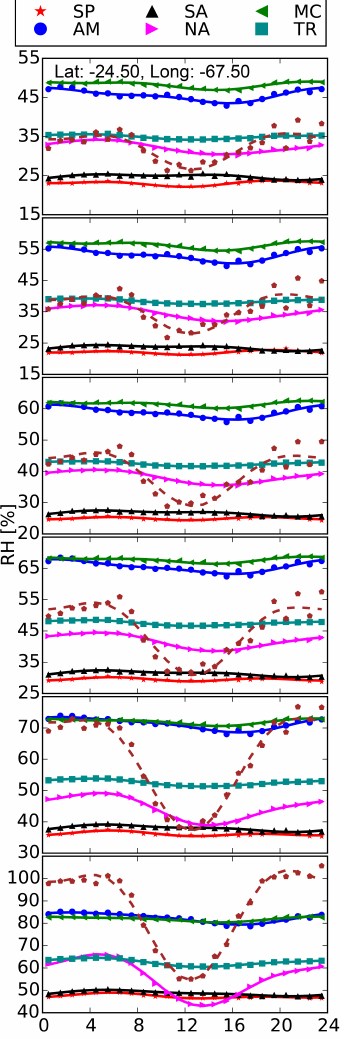
Figure 18. Same as Fig. 17 but the values are scaled between − 100 and